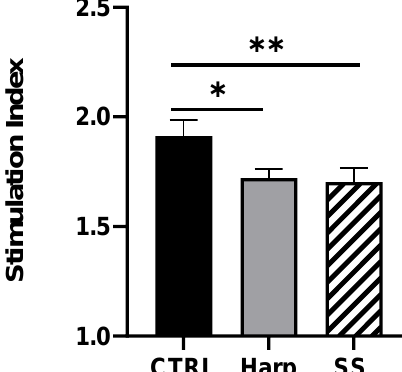
Figure 5. Allogeneic mixed lymphocyte reaction (MLR) in the presence or absence of 5 μM of each of Harp and SS. Average simulation index of triplicates is plotted ±S.E. Statistically significant di ff erences compared with untreated CTRL MLR are indicated with asterisks (* p = 0.0578 and ** p = 0.0044, respectively). The data shown represent two biological